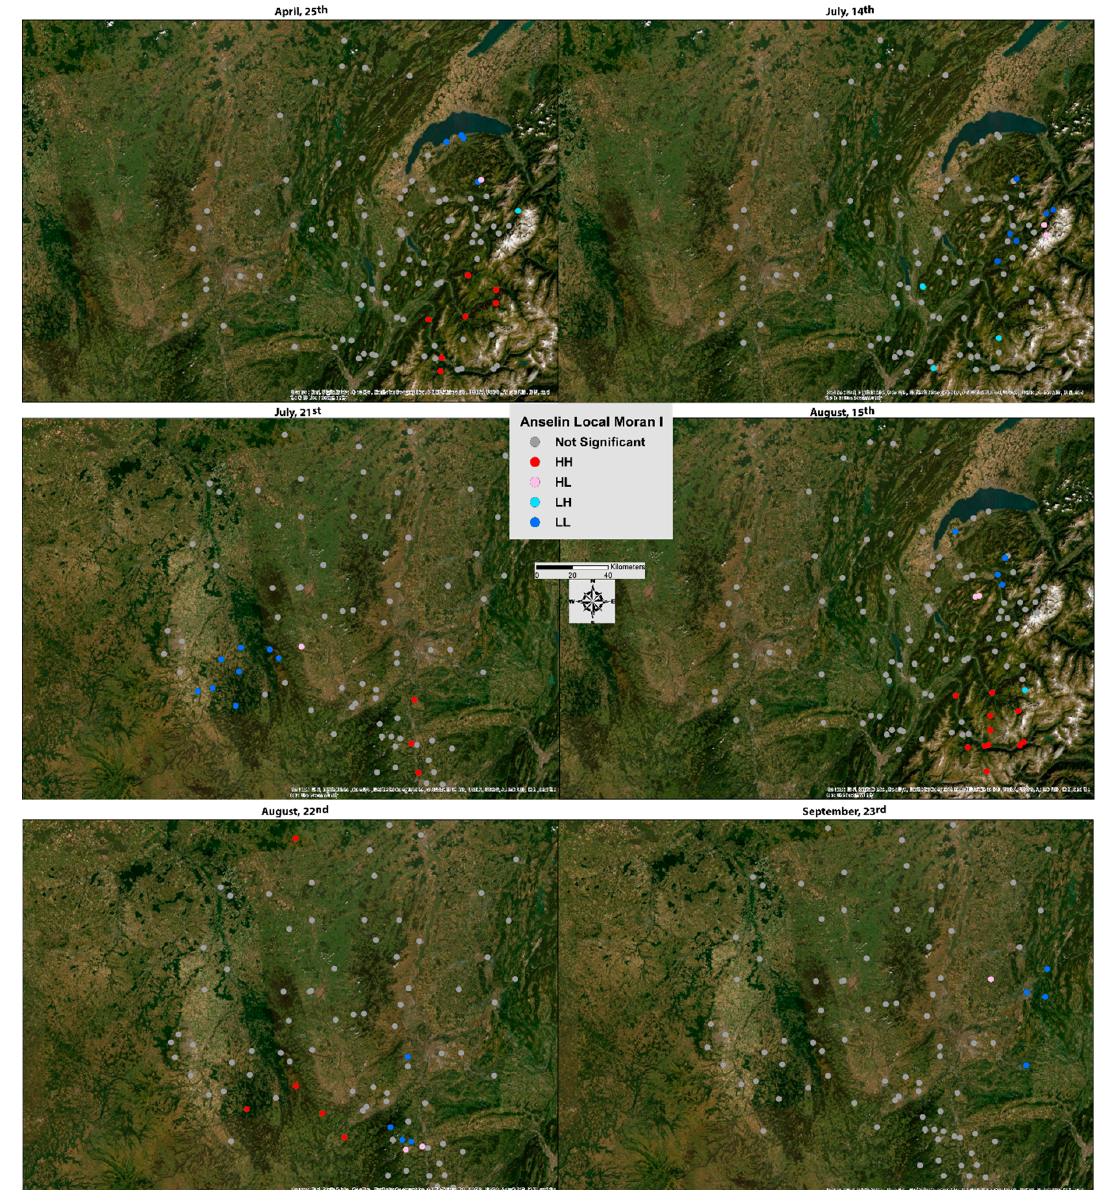
Figure 5. LISA of the relative differences between in situ and modelled air temperatures for each day studied.